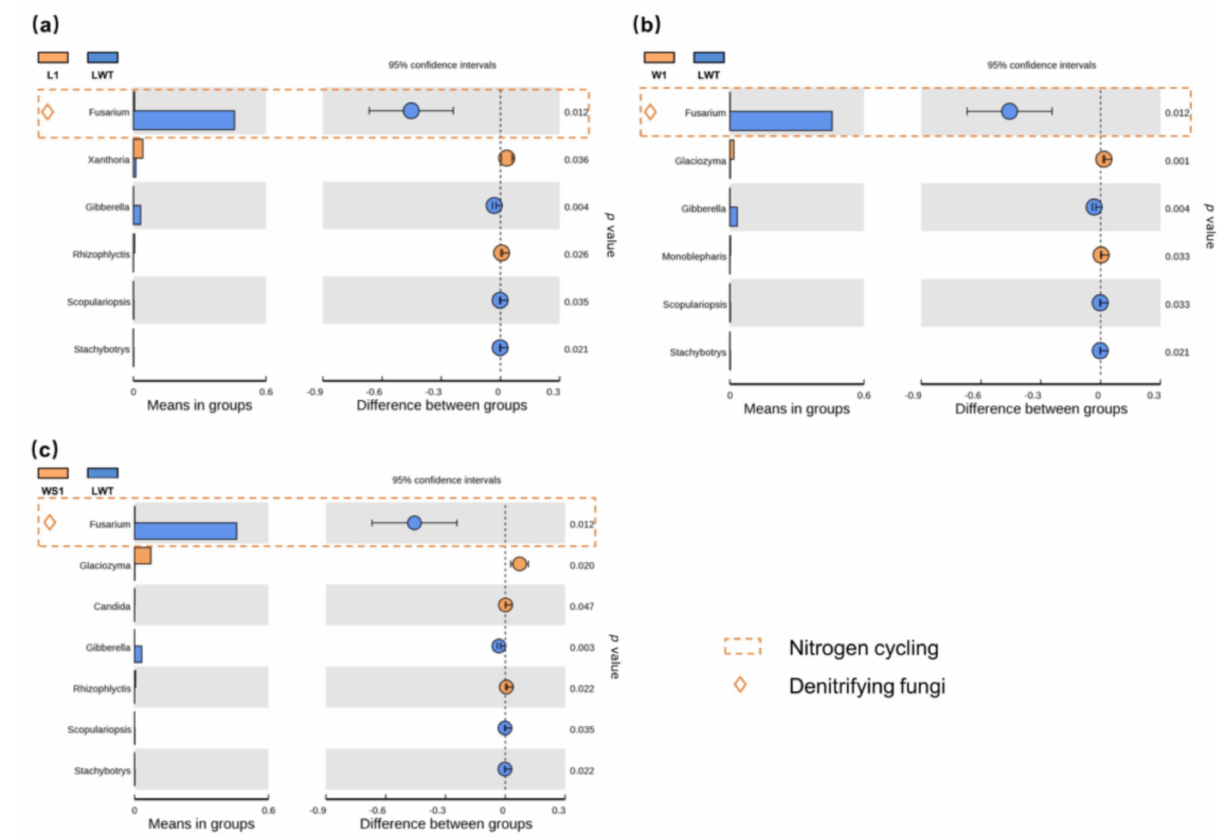
Figure 5. A comparison of the relative abundance of two soil fungal groups between restored and degraded Phragmites wetlands at the level of fungal genera. ( a ) comparison between L1 and LWT sites; ( b ) comparison between W1 and LWT sites; ( c ) comparison between WS1 and LWT sites. The significance of differences between the two groups was determined by a t -test with 95% confidence intervals. The orange dashed boxes represent typical bacteria concerned in nitrogen cycling. Denitrifying fungi are marked by orange